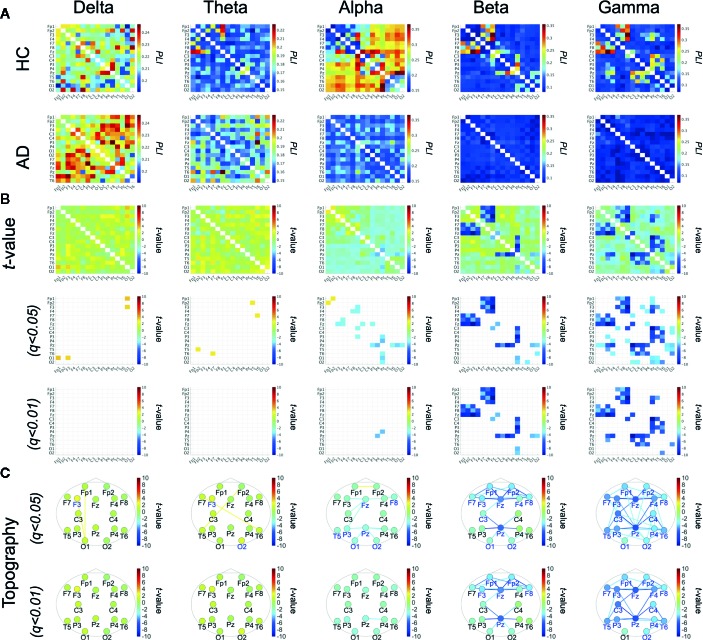

(A) Mean values of phase lag index (PLI) in the healthy control (HC) group and the Alzheimer's disease (AD) group. (B)
t-scores for differences between the HC and AD groups (top parts) and t-scores passing through the criteria adjusted for false discovery rate (FDR) q < 0.05, q < 0.01 (corresponding to) p < 5.90 × 10–3), p < 6.73 × 10–4, respectively) (middle and bottom parts). (C)
t-scores of PLI passing through the criteria adjusted for FDR: q < 0.05, 0.01 across the topography. t-scores for node degree (ND), where colored electrode labels correspond ones for passing through the criteria after adjustment FDR q < 0.05, q < 0.01 (corresponding to p < 0.0232 p < 2.51 × 10–3, respectively). Bluer (redder) colors represent the reduction (enhancement) of ND/PLI values in AD group.